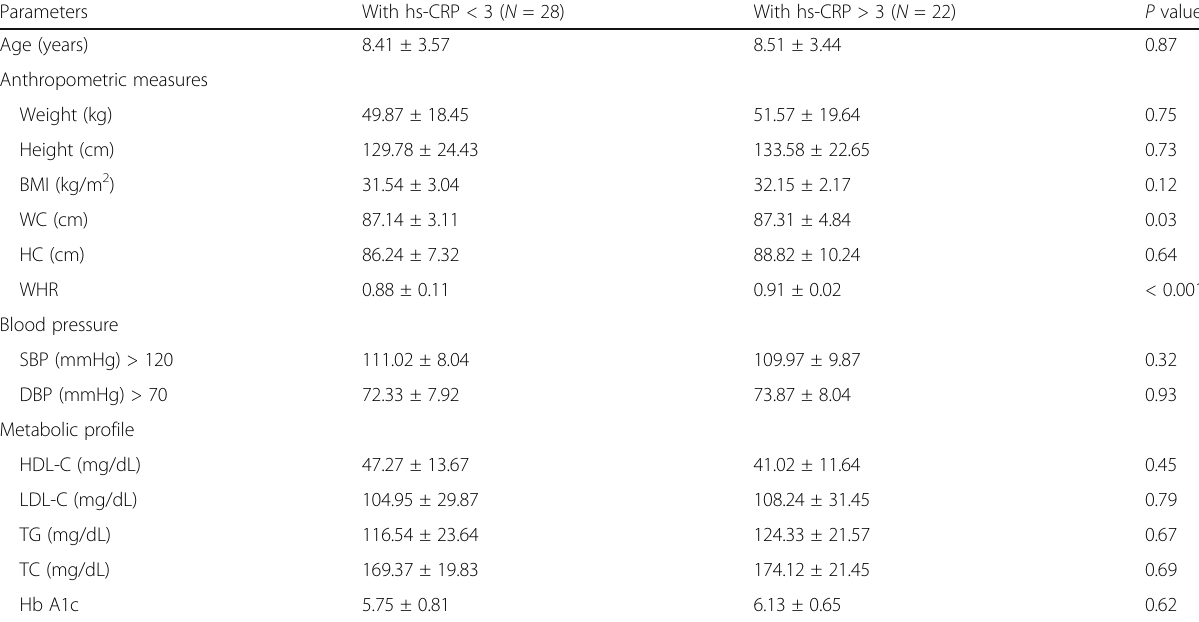
Table 5 Anthropometric and biochemical characteristics of the obese children according to hs-CRP level Parameters